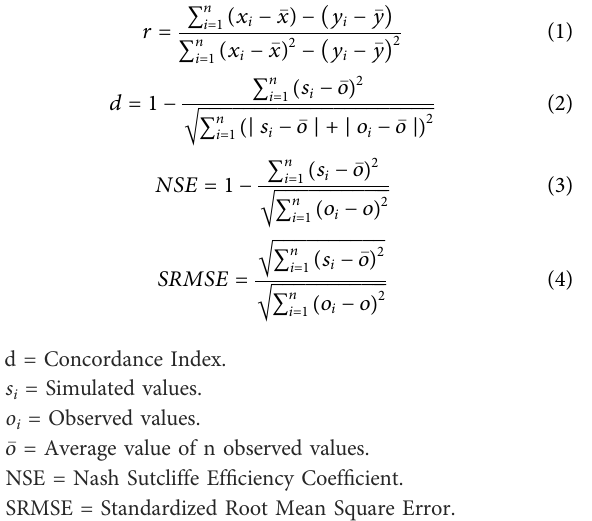
Radiation, Precipitation and Relative Humidity (Red: Precipitation; Green: Temperature; Blue: Relative Humidity; Magenta: Radiation). In Figures 9, 10 monitoring station and GFS wind rose during the period 10/2018 to 10/2019 are shown.